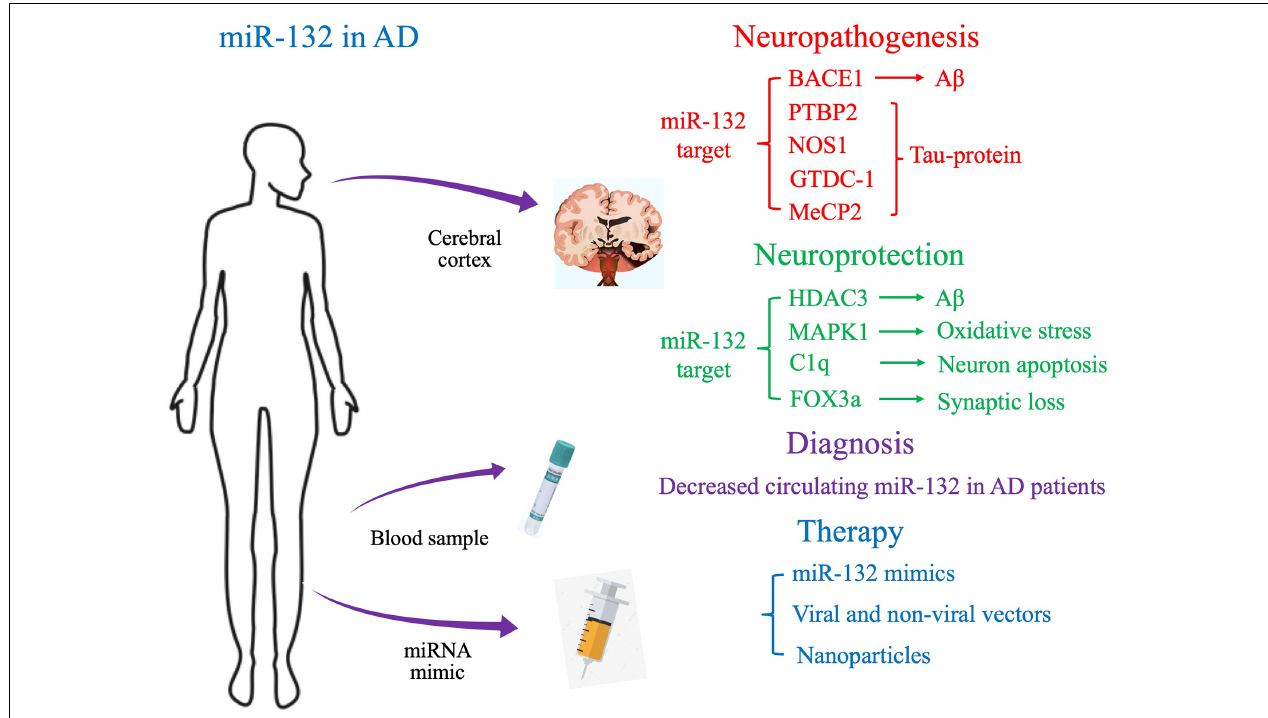
FIGURE 1 | Proposed molecular targets and clinical application of miR-132 in Alzheimer’s